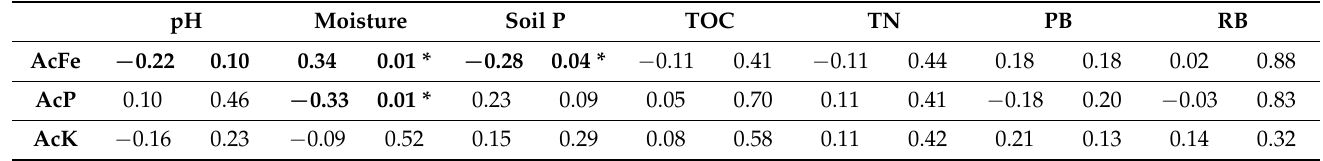
Figure 2. Drought, plant community composition and season influence the 16S rRNA diversity of Pseudomonas commu- nity. Abundances of strains representing fourteen 16S rRNA gene clusters are shown. The clusters 6–14 are grouped due to their low abundance. Five most abundant 16S rRNA gene clusters were closely related to the genes of P. koreensis (cluster C1), P. putida (C2), P. helmanticensis (C3), P. putida (C4, more distant C1) and P. vancouverensis (C5). Significant differences according to the ANOVA test are reported using the following convention: *** p < 0.001, ** p < 0.01, * p < 0.05.